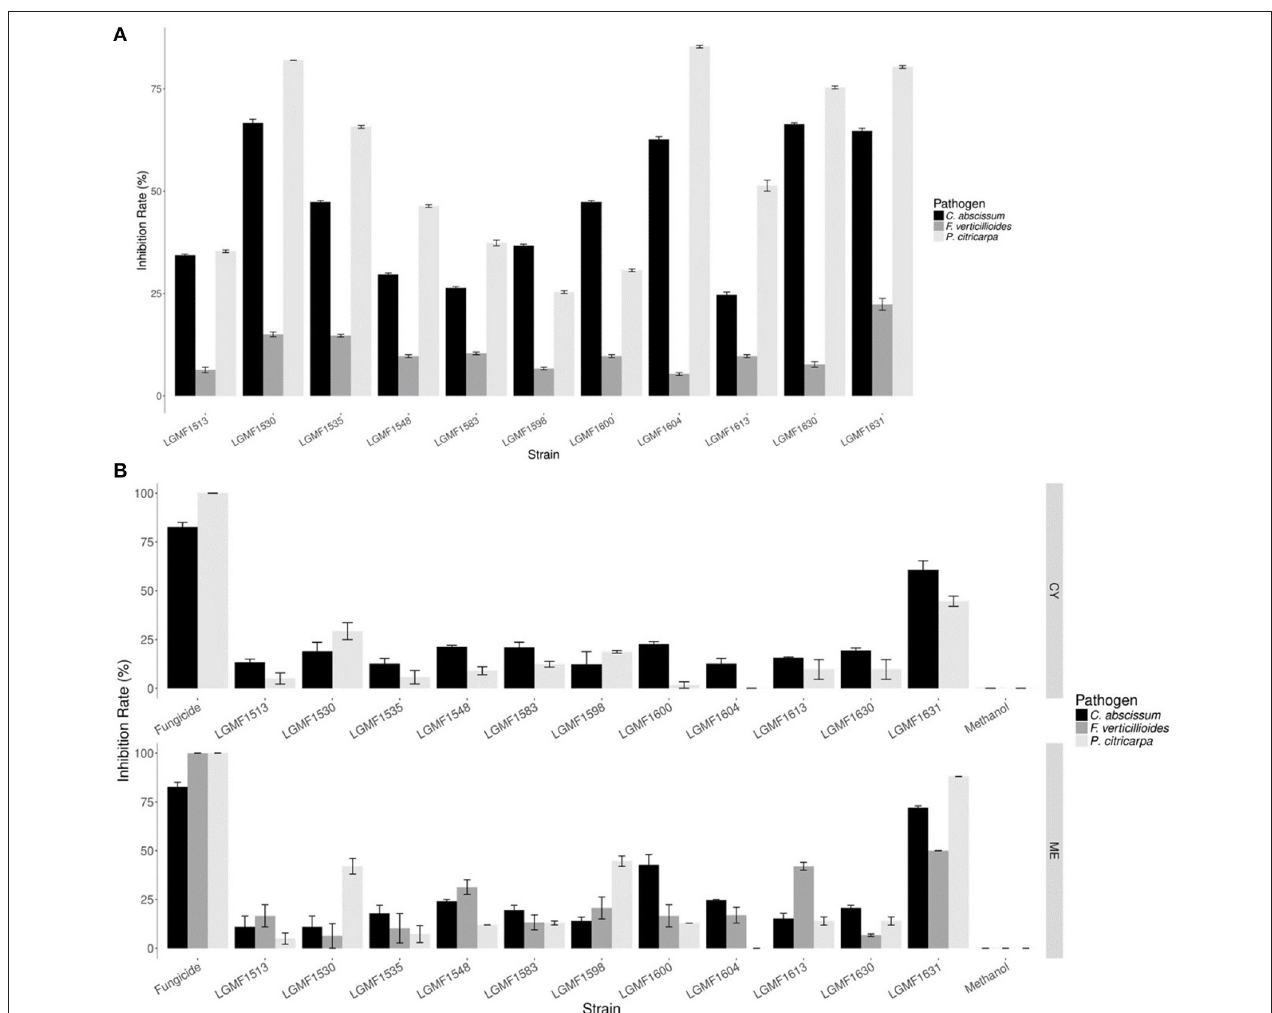
FIGURE 5 | Mean of inhibition growth (in %) of the pathogens Colletotrichum abscissum (in black), Phyllosticta citricarpa (light gray), and Fusarium verticillioides (dark gray) in the dual culture (A) . Mean of inhibition growth (in %) of the pathogens Colletotrichum abscissum (in black), Phyllosticta citricarpa (light gray), and Fusarium verticillioides (dark gray) in presence of 100 µ L of extracts obtained from cultivation of endophytes in different culture media (B) . Fungicide: 100 µ L of Carbendazim (0.1 mg/mL) was used from P. citricarpa and 100 µ L of Derosal (1.0 mg/mL) was used from C. abscissum and F. verticillioides